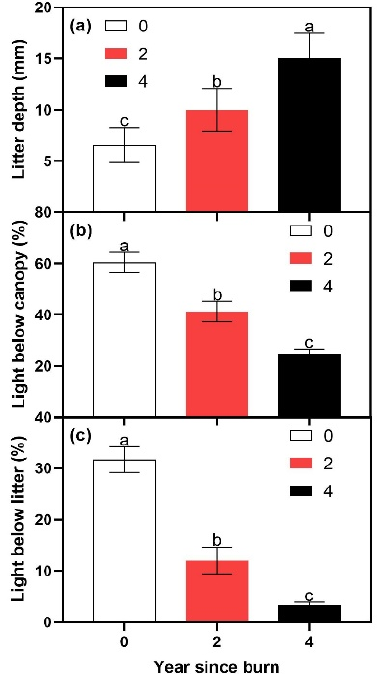
Figure 3. Litter depth ( a ) and percentage of light below canopy ( b ) and below litter ( c ) after zero, two, and four years after a prescribed fire. Error bars indicate the standard error. Means sharing a letter are not significantly different (Tukey’s HSD, α = 0.05).